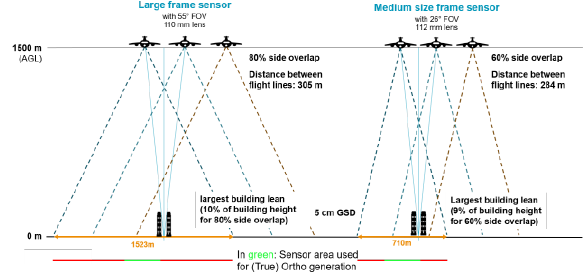
Figure 10: Building Lean vs. Side-Overlap, preferred configuration for TrueOrtho production